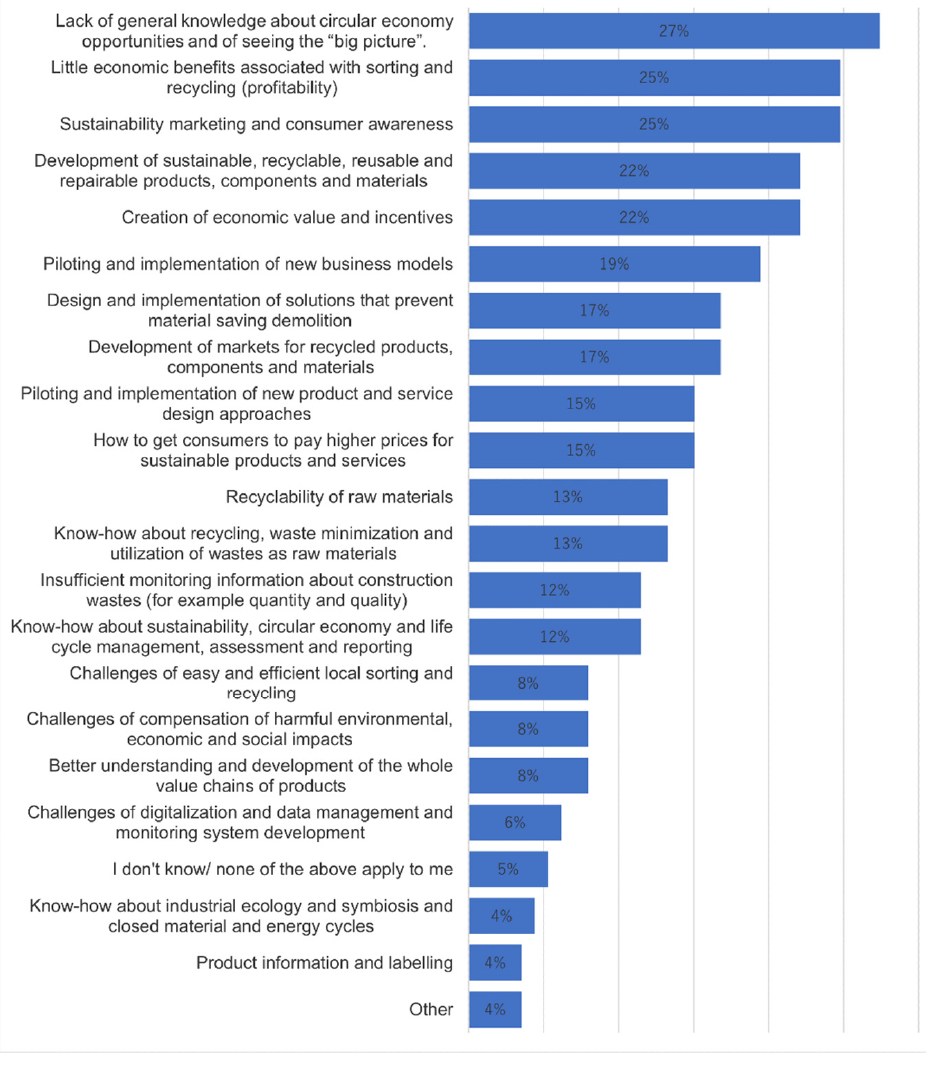
Figure 12. Technological, economical, and social barriers to circular economy that should be ad- dressed first.